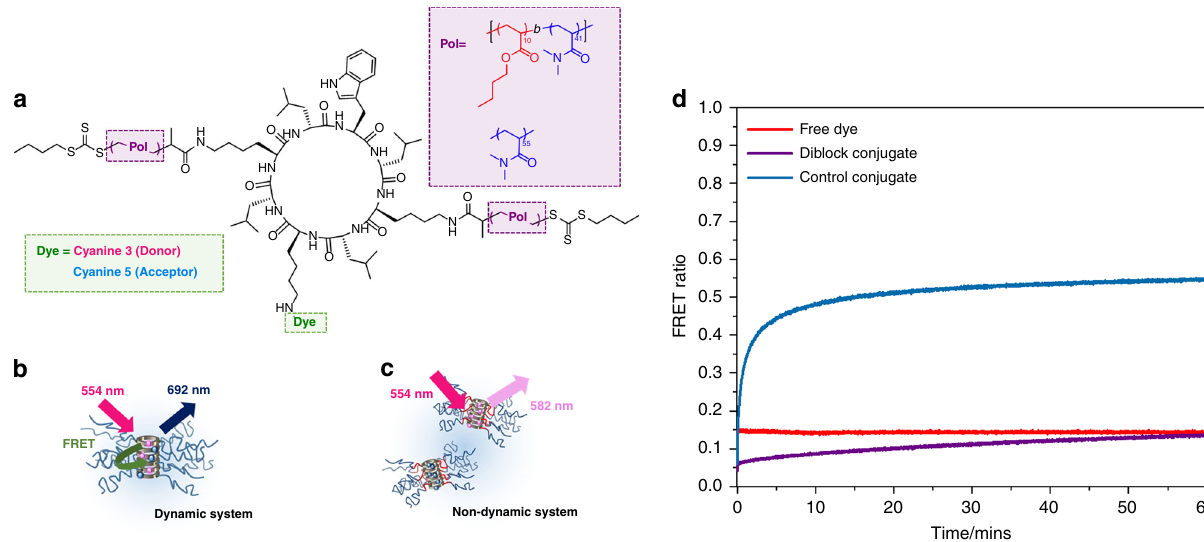
Fig. 4 Kinetics of cyclic peptide-polymer nanotubes. a The orthogonal functionalization of cyclic peptide (CP) with two polymer arms and a donor or acceptor FRET dye. b Schematic of stable non-exchanging CP-polymer nanotubes. c Scheme of dynamically exchanging mixed CP-polymer nanotubes. d Graph to show the change in FRET ratio over time measured using fl uorescence spectroscopy